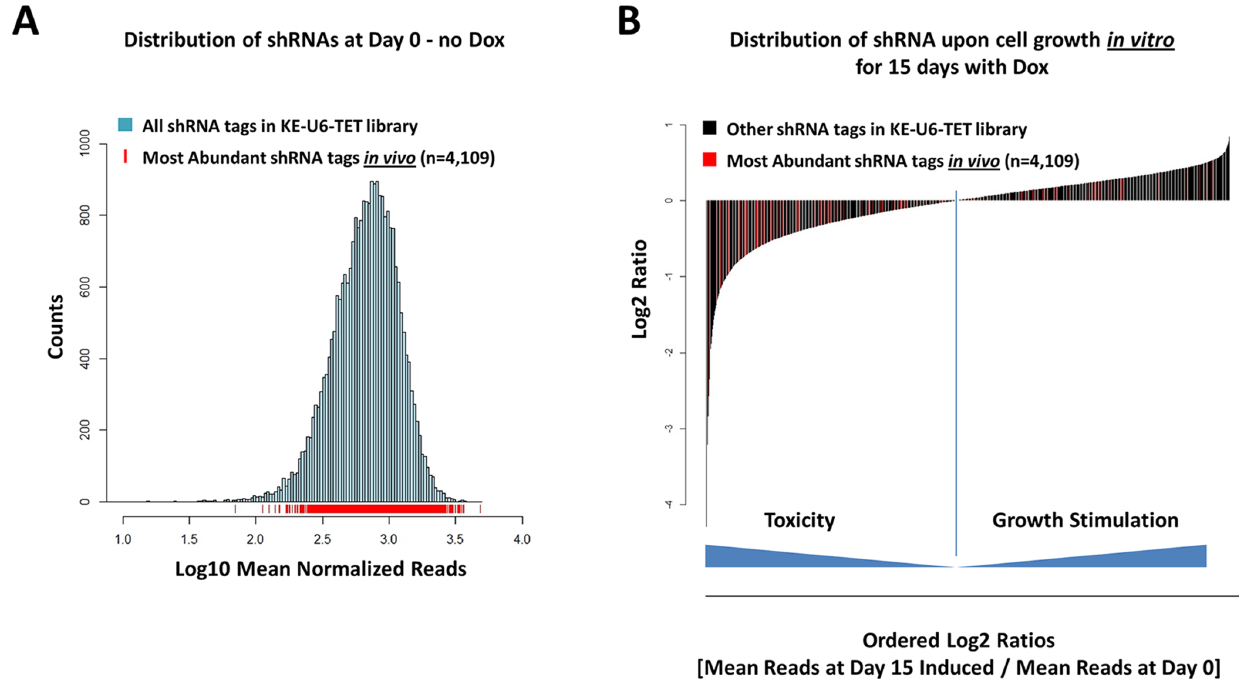
Figure 4. Evidence that encoded shRNA did not influence HCT-116 clonal cell growth invivo . (A) Distribution of the 4,109 unique barcodes retrieved most abundantly from the three xenograft tumors (marked with red vertical lines) across the entire shRNA population distribution in the shRNA library. (B) Detection of a large fraction of the most abundant barcodes from the three xenograft tumors (marked in red) in the shRNA population most toxic to HCT-116 upon Doxycycline induction in vitro for 15 days (measured by a negative Log2 ratio of mean read counts for individual shRNA at Day 15 following Doxycycline to mean read counts at Day 0).